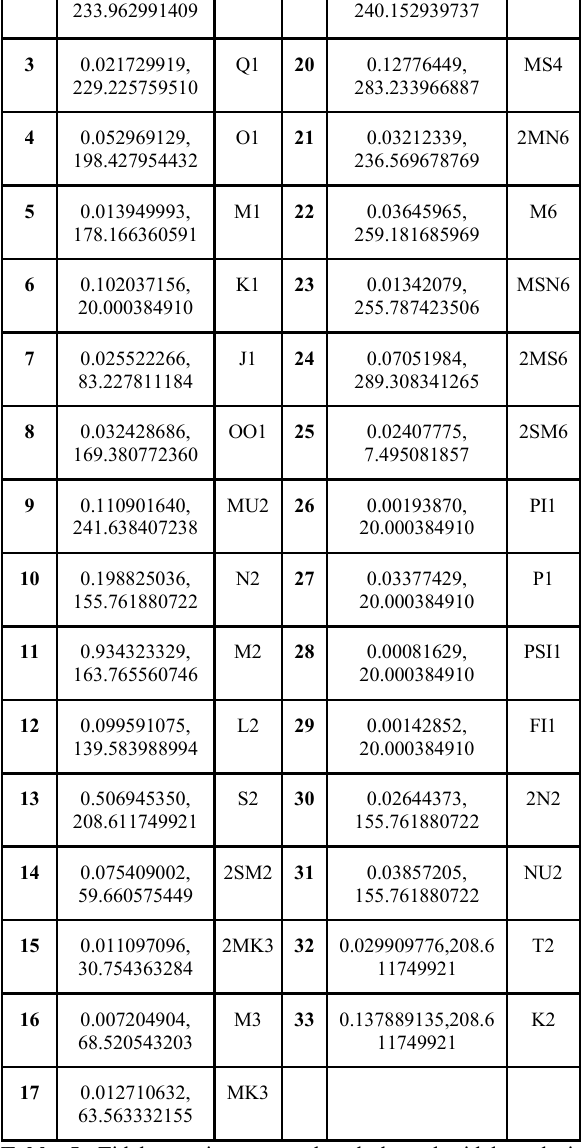
Table 5. Tidal constituents produced through tidal